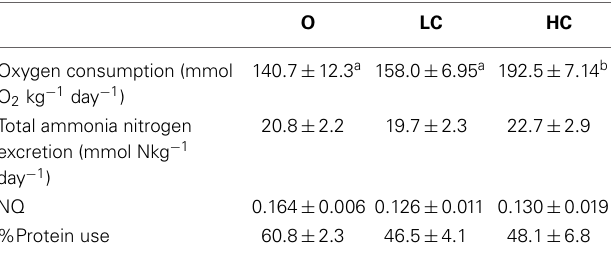
Table 1 | Oxygen consumption, ammonia excretion rates, and nitrogen quotients (NQ) for groups of fish subjected to different water current